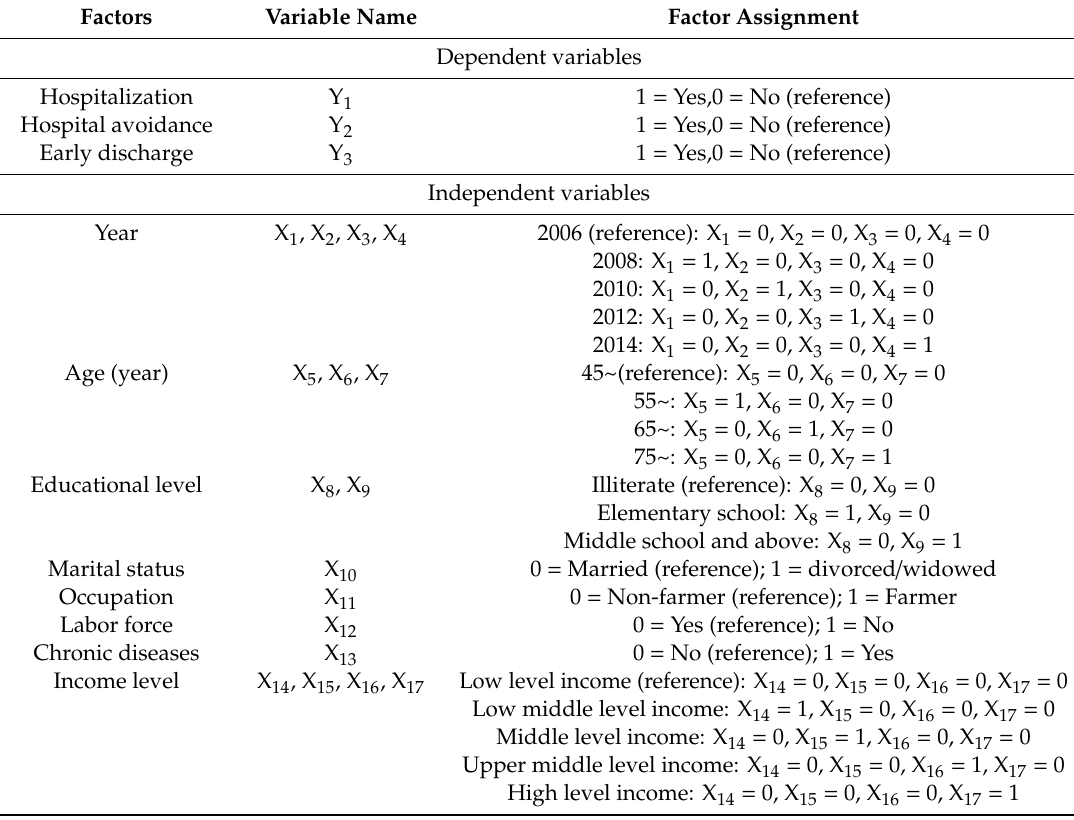
Table 5. The variable assignment summary for complex sampling logistic regression